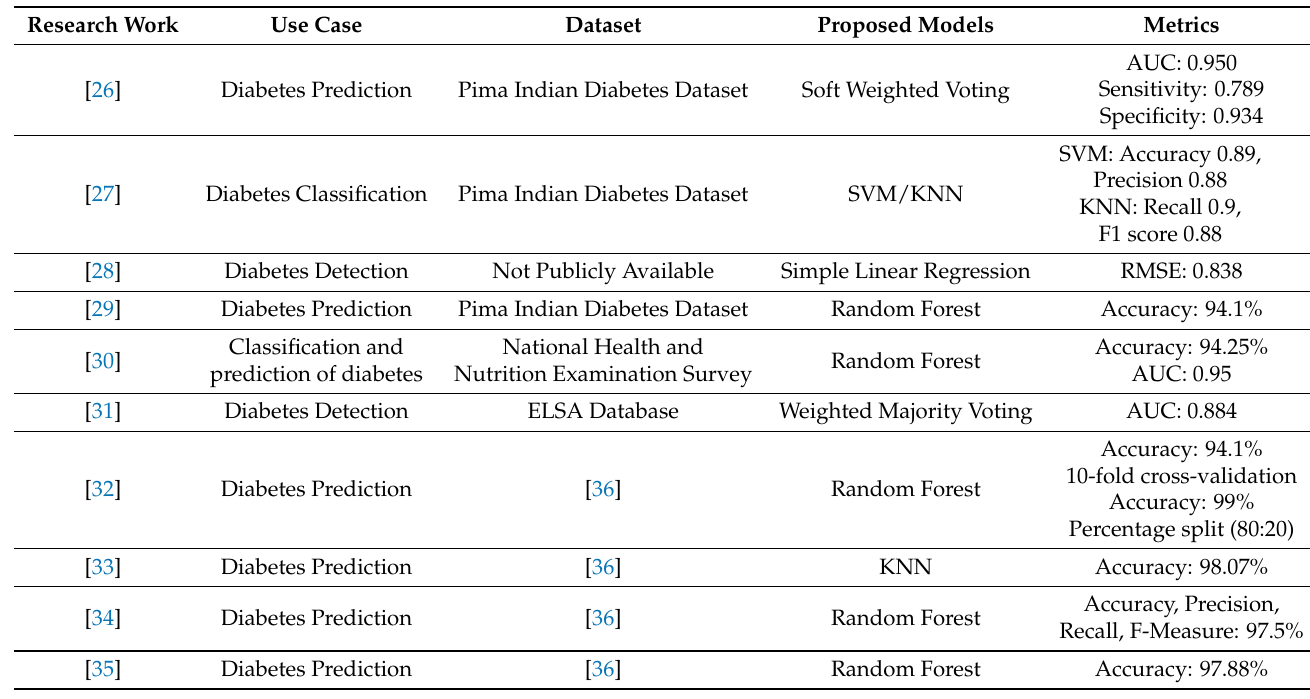
Table 1. Related works for the subject under